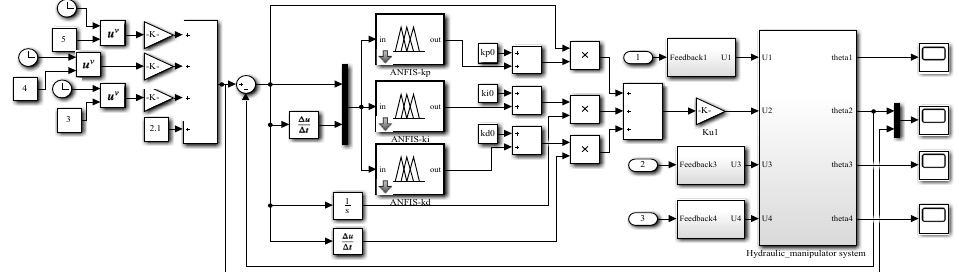
Figure 9. Simulation model of the ANFIS-PID control system.